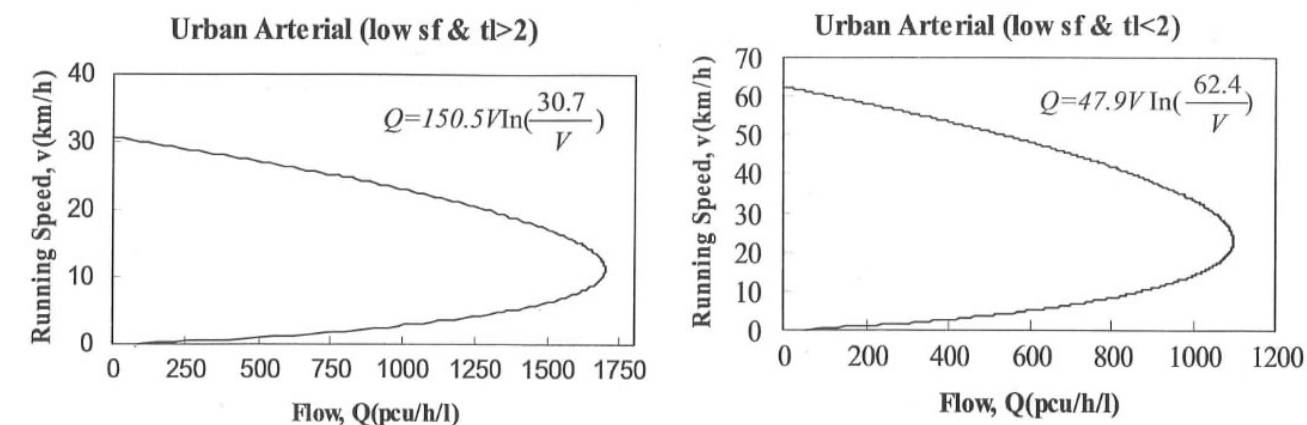
Figure 1. Speed-flow relationship models for urban roads networks [2].